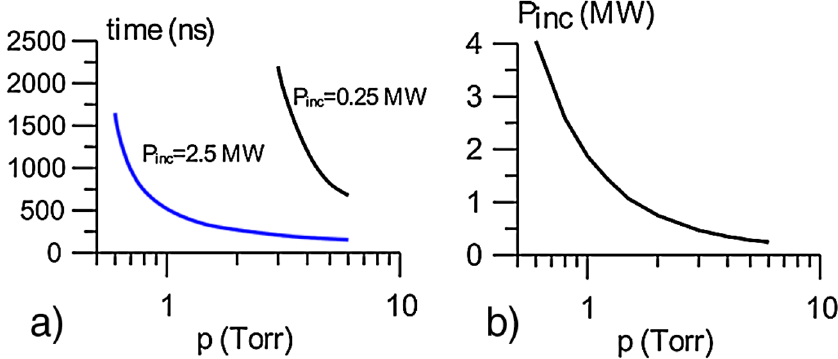
FIG. 13. (Color) (a) Breakdown evolution time as a function of air pressure for different incident powers P inc . (b) Maximum power of the input pulse as a function of air pressure in the grating (input pulse duration t ¼ 700 ns